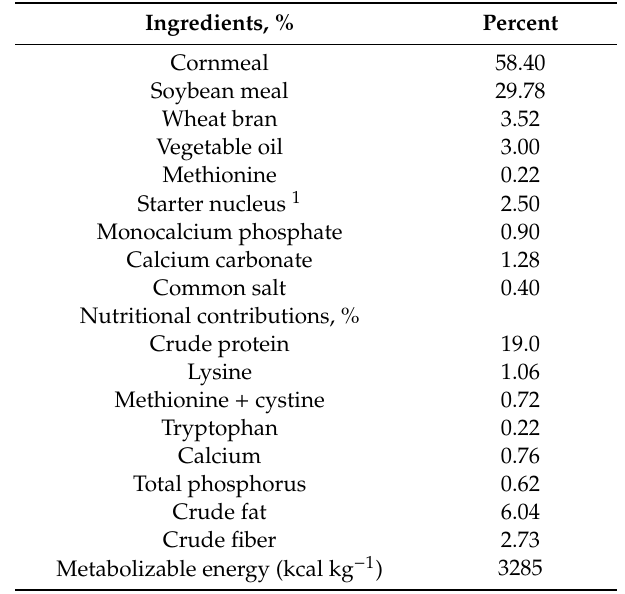
Table 1. Ingredients and nutritional contributions of the pig diet (21–49